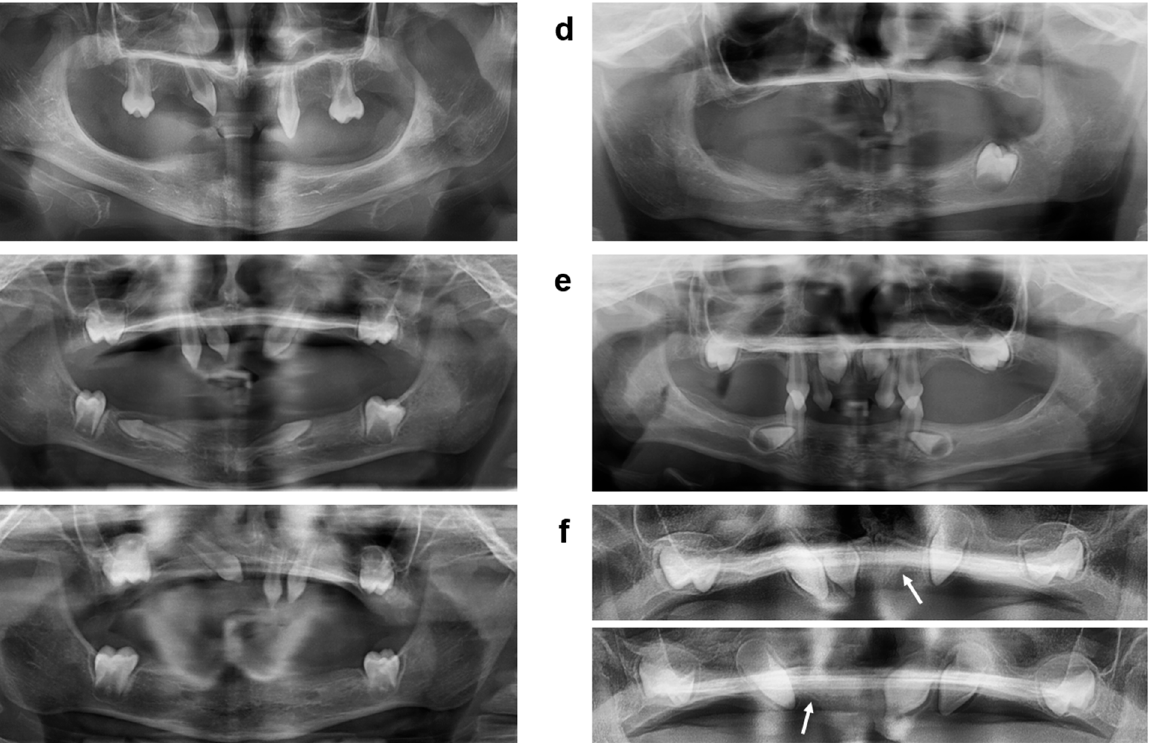
Figure 3. Panoramic dental radiographs of the untreated XLHED-affected brother ( a ) of subjects P1 and P2 compared with the radiographs of these Fc-EDA-treated subjects at preschool age ( b , c ) and of the untreated affected brother of P3 ( d ) compared with the younger sibling 6 years after his prenatal treatment with Fc-EDA ( e ). Two primary tooth germs (( f ), arrowed) that had been detectable in P1 and P2 in early infancy did not undergo complete mineralization and did not erupt.